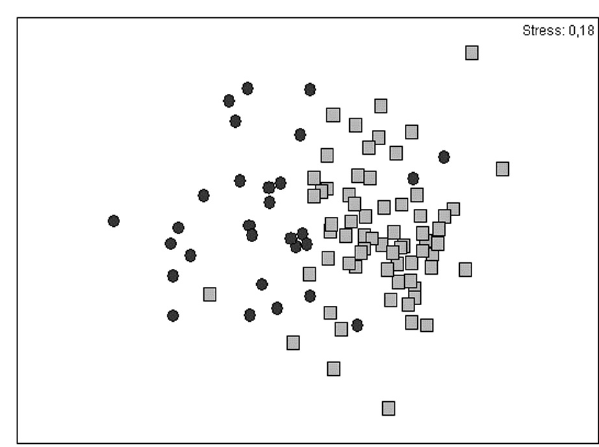
F IG . 3. – MDS ordination plot for the CAHO (circle) and FKLD (squares) regions. T ABLE 3. – Results of the SIMPER analysis of presence/absence data of polychaete species from the CAHO and FKLD quadrants. Species are listed in the order of their contribution to the average dissimilarity between both groups after Longhurst (1998). Diss: Dissimilarity; SD: Standard deviation. Mean Diss Diss /